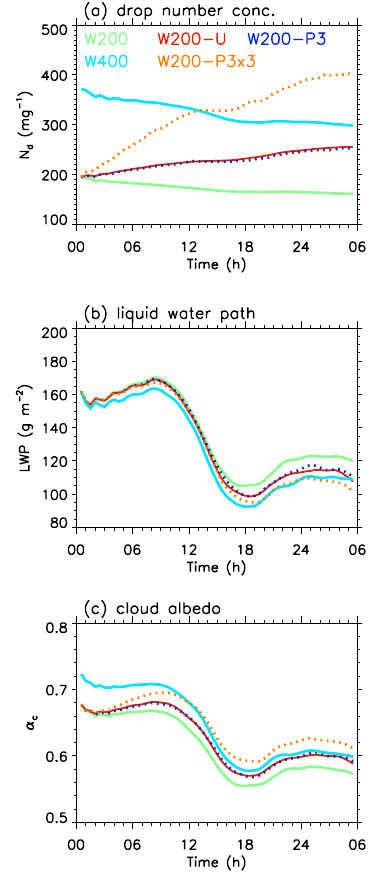
Fig. 7. Time evolution of (a) cloud drop number concentration ( N d , mg − 1 ) , (b) domain-average liquid water path, LWP (gm − 2 ), and (c) domain-average cloud albedo α c for experiments in the W200 series and two additional ones: W400 (same as W200 but initial N c is 400mg − 1 ) and W200-P3 × 3 (same as W200-P3 but the injection rate is